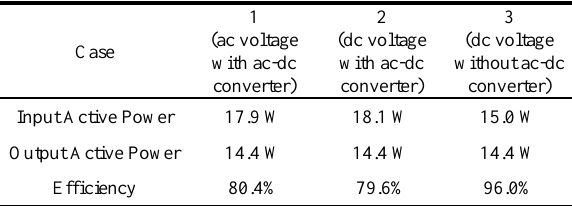
Table 2. Power and efficiency comparison for the three cases obtained in simulation.